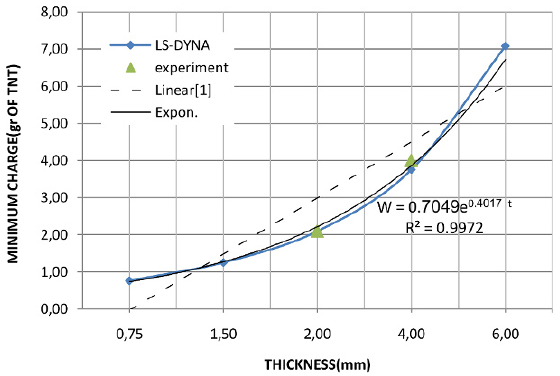
Figure 16. Linear and exponential approximations of the required charge for 200 mm diameter.